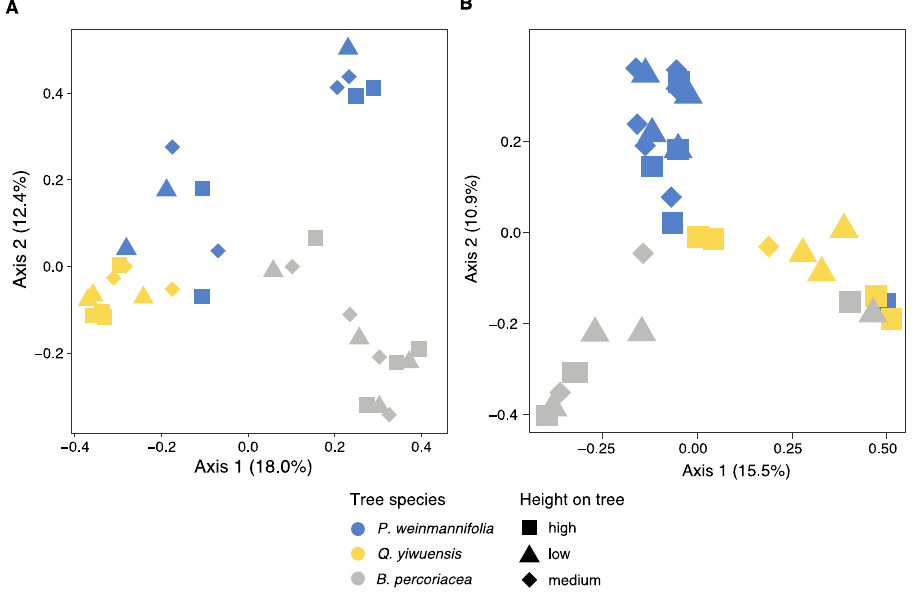
Figure 5. Total ( A ) and orchid-associated ( B ) fungal community structure of the bark from the host tree where the orchids were collected.